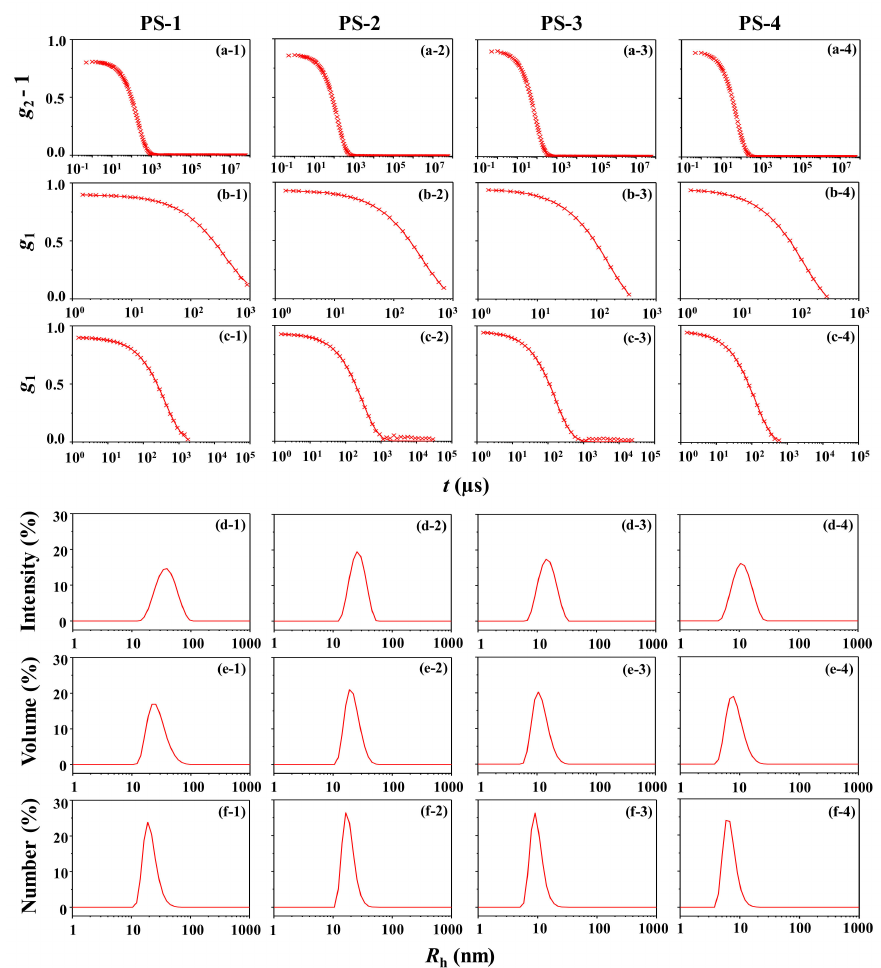
Figure 2. DLS analyses of PS nanoparticles at 25 ◦ C: ( a-1 to a-4 ) autocorrelation profiles measured; ( b-1 to b-4 ) data analysis results, where the symbols are the measured data and the red solid lines were obtained by fitting the data using the cumulant method in the Zetasizer program package; ( c-1 to c-4 ) data analysis results, where the symbols are the measured data and the red solid lines were obtained by fitting the data using the non-negatively constrained least square (NNLS) deconvolution algorithm included in the Zetasizer program package; ( d -1 to d-4 ) intensity-weighted radius distributions obtained by the data analyses; ( e ) volume-weighted radius distributions obtained from the radius distributions in ( d-1 to d-4 ) and ( f ) number-weighted radius distributions obtained from the radius distributions in (e-1 to e-4